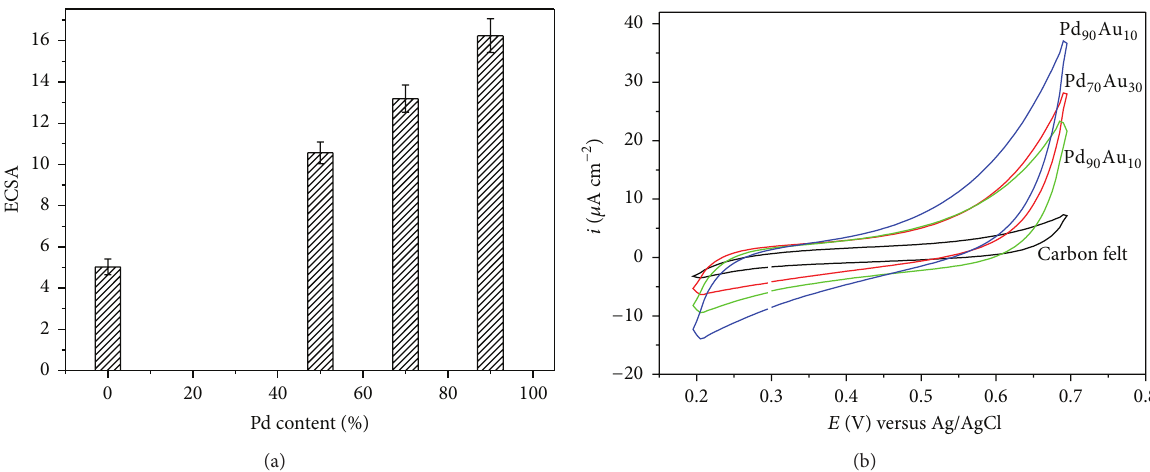
Figure3:(a)VariationofECSAwithPdcontent;(b)cyclicvoltammogramsobtainedwithPd-Auindifferentratiosoncarbonfeltinphosphate buffer (pH 7.0); scan rate 10 mV/s (current density is calculated with respect to the electrode geometric area).